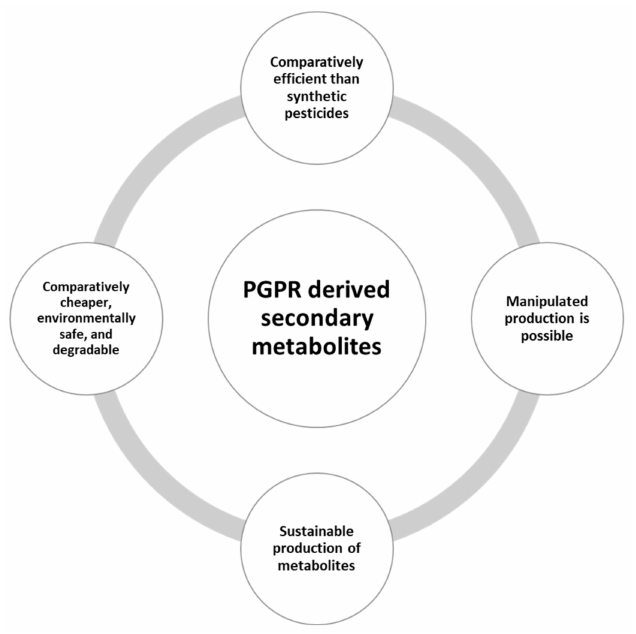
Figure 3. Multifunctional features of PGPR-derived secondary